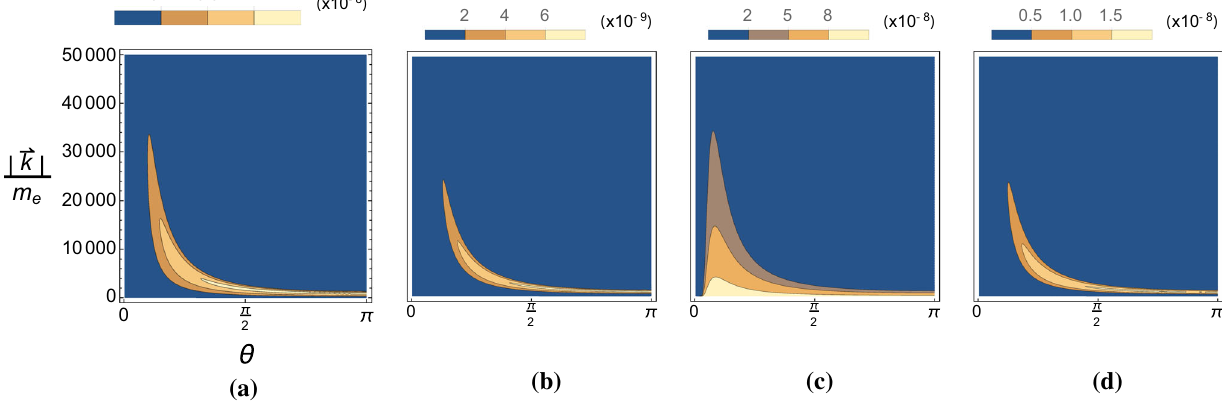
Fig. 13 The pseudo-scalar (left) and scalar (right) yields, P ± , are plotted as a function of the polar angle and momenta of the emitted ALP in a Gaussian background for two different ALP masses. Also, χ p , 0 has been fixed to 1. a P − , δ = 0, b P − , δ = 0 . 6, c P + , δ = 0, d P + , δ = 0 . 6 ( ϕ ∗ ) 2 g (cid:8) (ϕ ∗ ) = e − cos ϕ ∗ (cid:16)